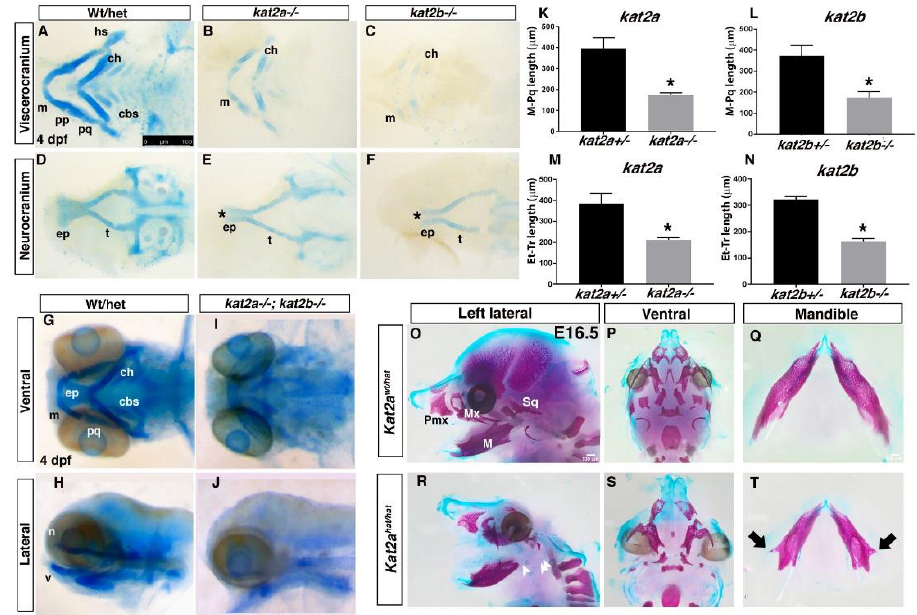
Figure 2. Loss of kat2a and kat2b causes defects in craniofacial development. Alcian blue staining to detect cartilage formation in 4 dpf (days post fertilization) wildtype/heterozygote zebrafish embryos ( A , D , G , H ), kat2a − / − ( B , E ), kat2b − / − ( C , F ), and kat2a − / − ; kat2b − / − double mutant zebrafish embryos ( I , J ). ( A – F ) Cartilage-stained embryos were dissected to separate the viscerocranium and the neurocranium. As compared to the control ( A , D ), the flat-mounted 4 dpf kat2a ( B , E ) and kat2b ( C , F ) mutant larvae have a reduced palatoquadrate, including the pterygoid process of the palatoquadrate and the hyosymplectic of the viscerocranium, shortening of the Meckel’s cartilage, widening of the angle between ceratohyals in the viscerocranium, a smaller hypoplastic ethmoid plate, and deformed trabeculae of the neurocranium, with hypoplastic ceratobranchial cartilages that are also reduced in number. In the kat2a and kat2b mutant embryos, there is a gap in the anterior edge of the ethmoid plate that forms a “cleft” as shown (*) in ( E , F ). Cartilage defects were observed in n = 17/62 for kat2a and n = 16/66 for kat2b , with the total number of mutant embryos being n = 20/72 for kat2a and n = 17/70 for kat2b in each clutch. ( G – J ) Ventral and lateral views of whole-mount, alcian-blue-stained cartilage of control ( G , H ) and kat2a − / − ; kat2b − / − double mutants ( I , J ). ( K – N ) Quantitation of length in micrometers ( µ m) from Meckel’s cartilage to palatoquadrate (M–Pq), and from ethmoid plate to trabeculae (Et–Tr), in kat2a and kat2b mutants shows a significant reduction in length. * denotes statistical significance ( p < 0.05) using Welch’s T-Test. Error bars show the standard error of the mean. ( O – T ) Whole-mount E16.5 Kat2a Wt/hat ( O – Q ) and Kat2a hat/hat ( R – T ) embryo skeletons stained with alcian blue for cartilage and alizarin red for bone. ( O , R ) Left lateral view of skull. ( P , S ) Ventral view of skull with the mandible dissected off. ( Q , T ) Dorsal view of the dissected mandible. The arrows in T point to ectopic bone growth on the mandible (ectopic bone growth observed in n = 3). The arrow heads in R point to the missing first arch elements. cb, ceratobranchials; ch, ceratohyal; e, ethmoid plate; hs, hyosymplectic; Mx, Maxilla, M, Mandible; m, Meckel’s cartilage; n, neurocranium; pp, pterygoid process; pq, palatoquadrate; Pmx, Pre-maxilla; Sq, Squamosal; t, trabeculae; v, viscerocranium. The scale bars represent 100 µ